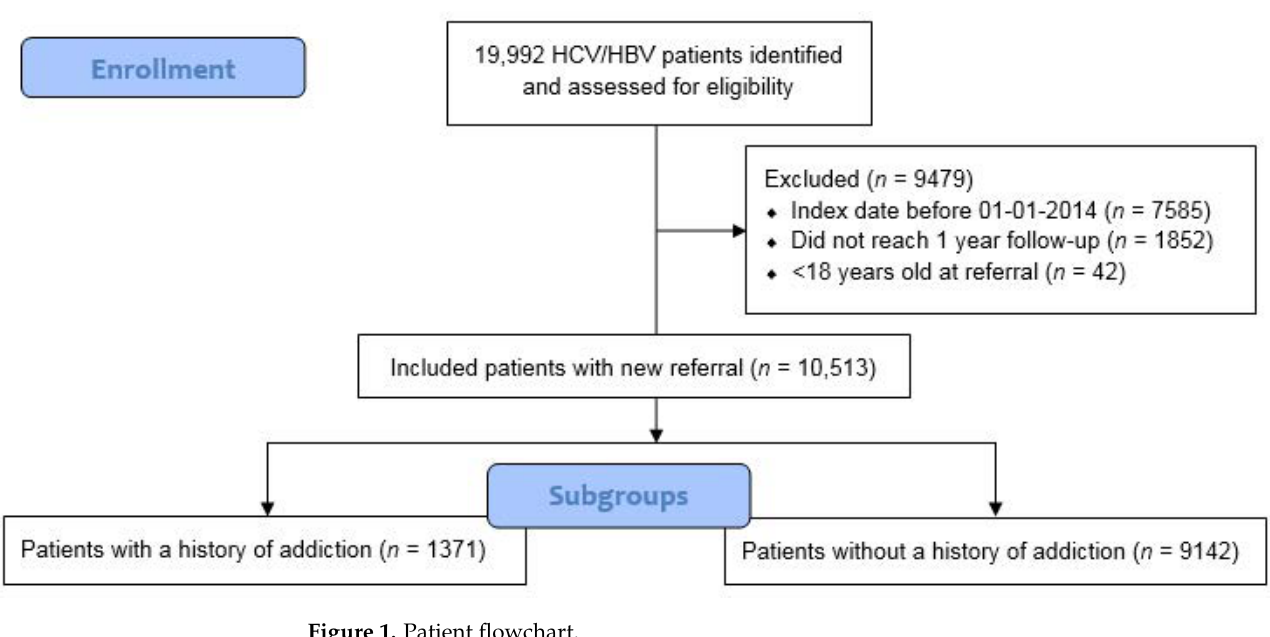
Figure 1. Patient flowchart.